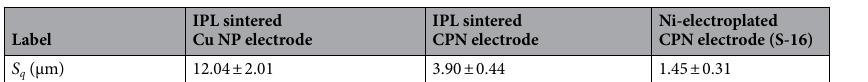
Table 9. Surface characterization parameters of three kinds of electrodes (Observation Area: 831 μm × 623